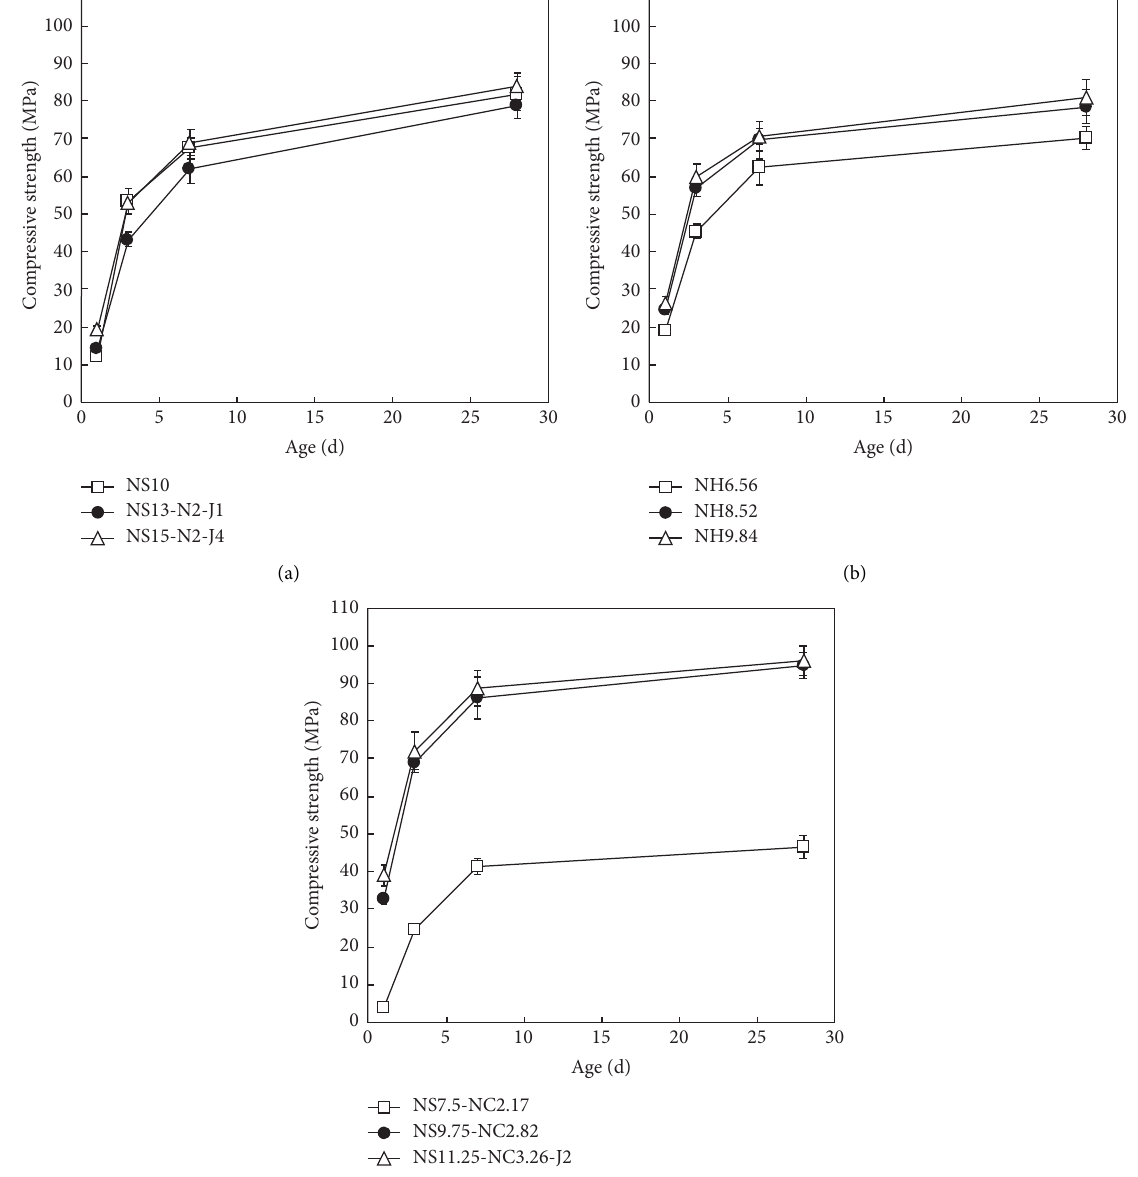
2 SiO 3 (a), NaOH (b), and Na 2 SiO 3 /Na 2 CO 3 (c), on the compressive